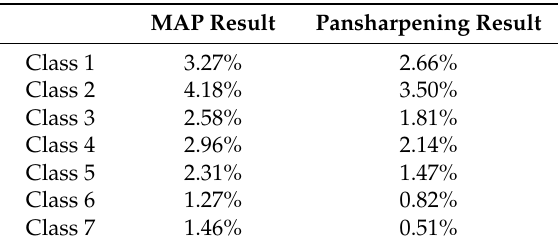
Figure 9. SRTM in experiment 1 ( 2 S  ). ( a ) Reference image; ( b ) BI result; ( c ) BIC result; ( d ) MAP result; ( e ) MTC result; ( f ) PTC result.